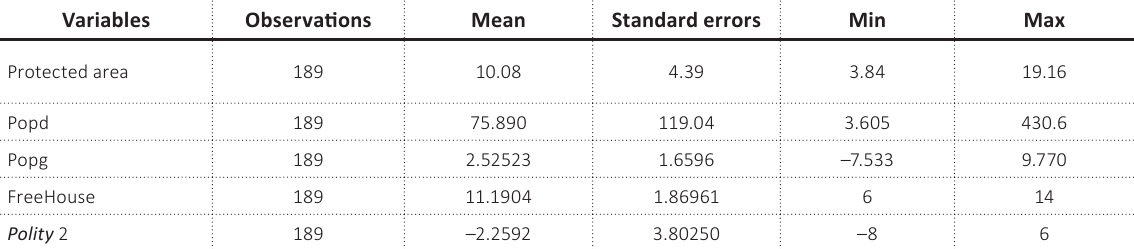
Table 1. Description of the